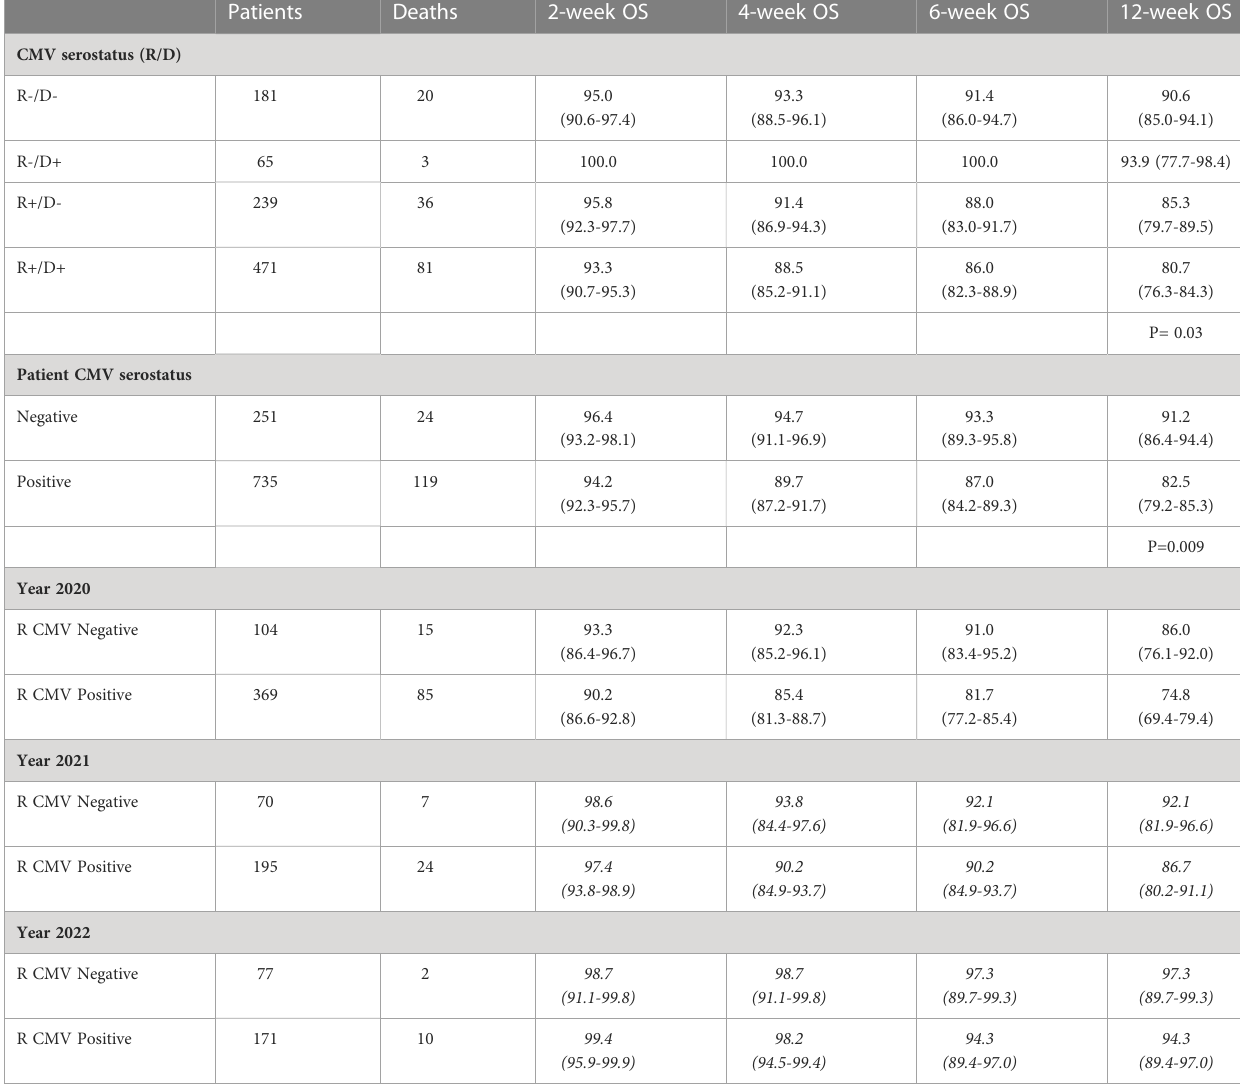
TABLE 3 Effect of CMV serostatus on overall survival for the different